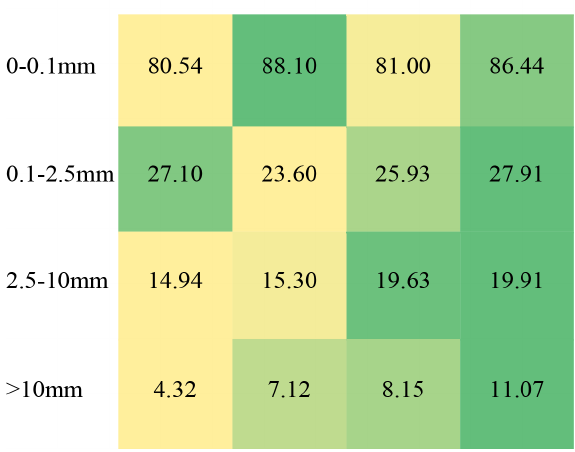
Table 5. The intersection over union (IOU) comparing coarsened Stage IV with raw MERRA2, QDM and two DL experimental runs with classification task (Scenario3 and